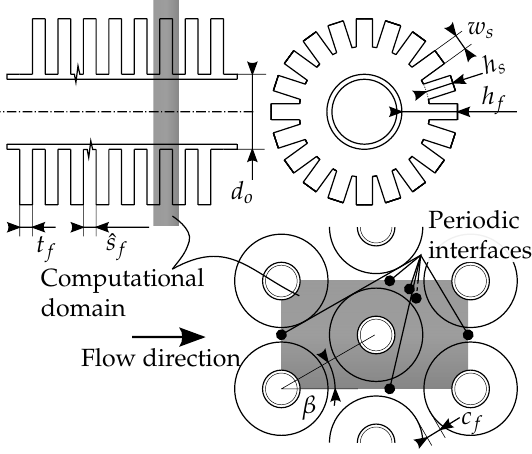
Figure 2. Figure 2. Geometric parameters of the fin-tube bundle and CFD computational